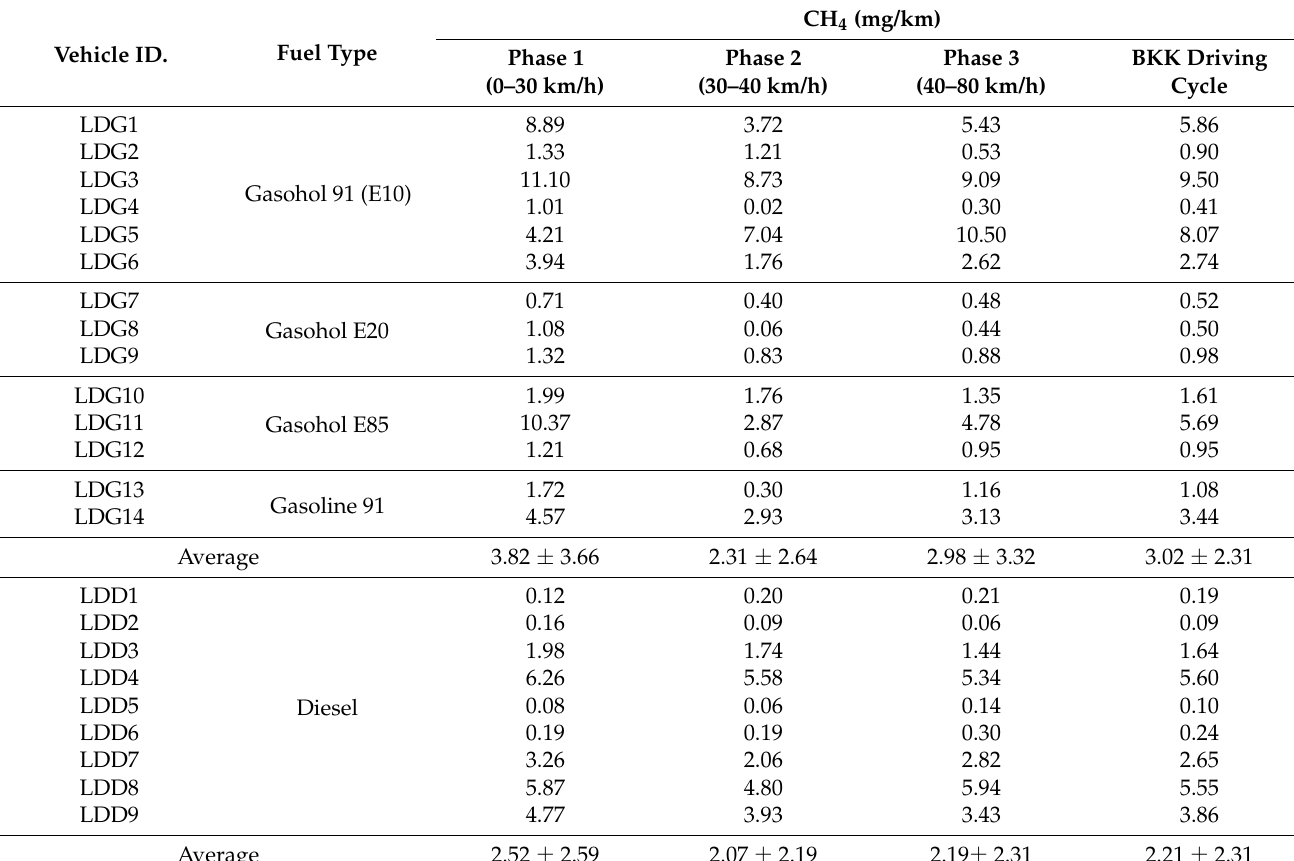
Table 4. CH 4 emission factors from LDG and LDD vehicles by fuel types and speed ranges.